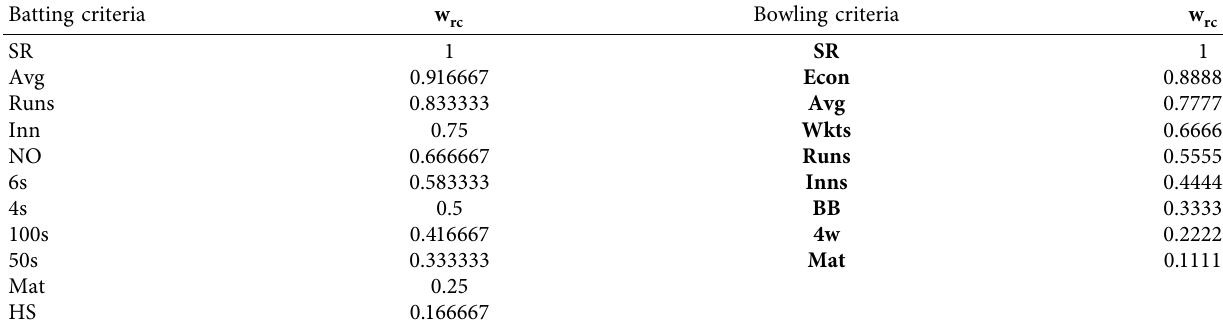
Table 9: Table of updated weights.